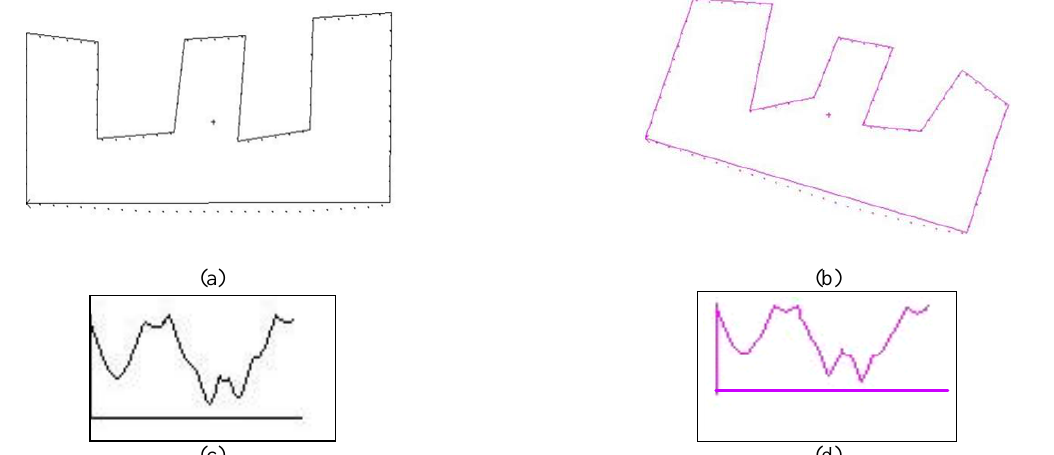
Figure.2 Polygons and corresponding shape curves. (a) polygon A. (b) polygon B. (c) shape curve of polygon A. (d) shape curve of polygon B that have been shift to the satisfied matching